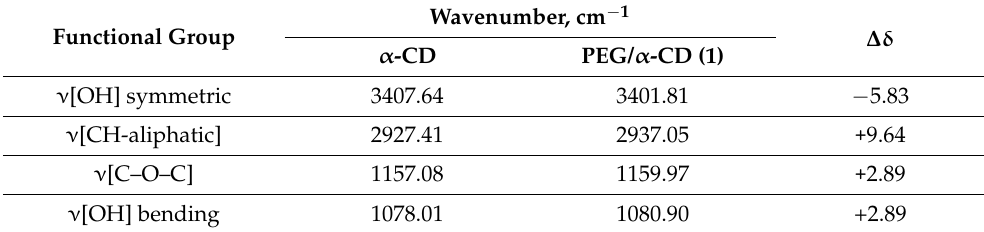
Table 1. FT-IR difference between pure α -CD and PEG/ α -CD (1) .